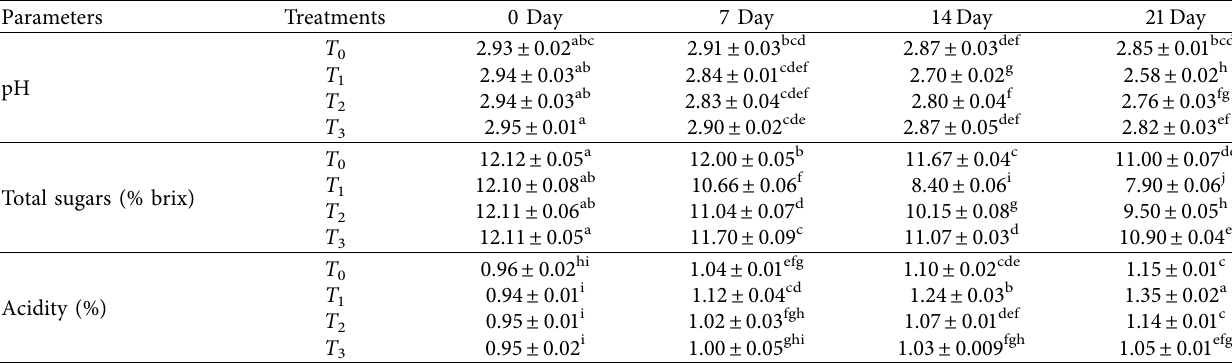
Figure 2: Storage stability of free and encapsulated L. rhamnosus at diferent intervals (0, 7, 14, and 21days). T T 2 � sodium alginate (1.5%) encapsulated L. rhamnosus ; T 3 � sodium alginate (1.5%)- and xanthan gum (0.5%)-encapsulated L. rhamnosus . Table 3: Physicochemical analysis of free and encapsulated L. rhamnosus -treated orange juice. Parameters